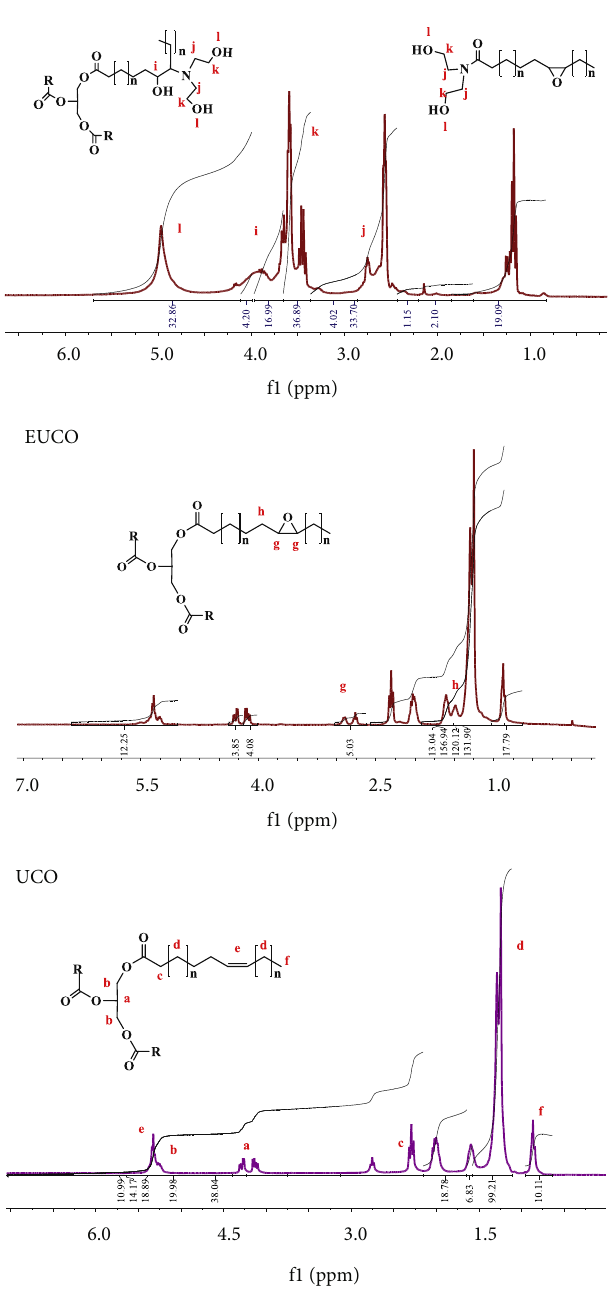
Figure 8: UCO, EUCO, and EUCO-OL 1 HNMR